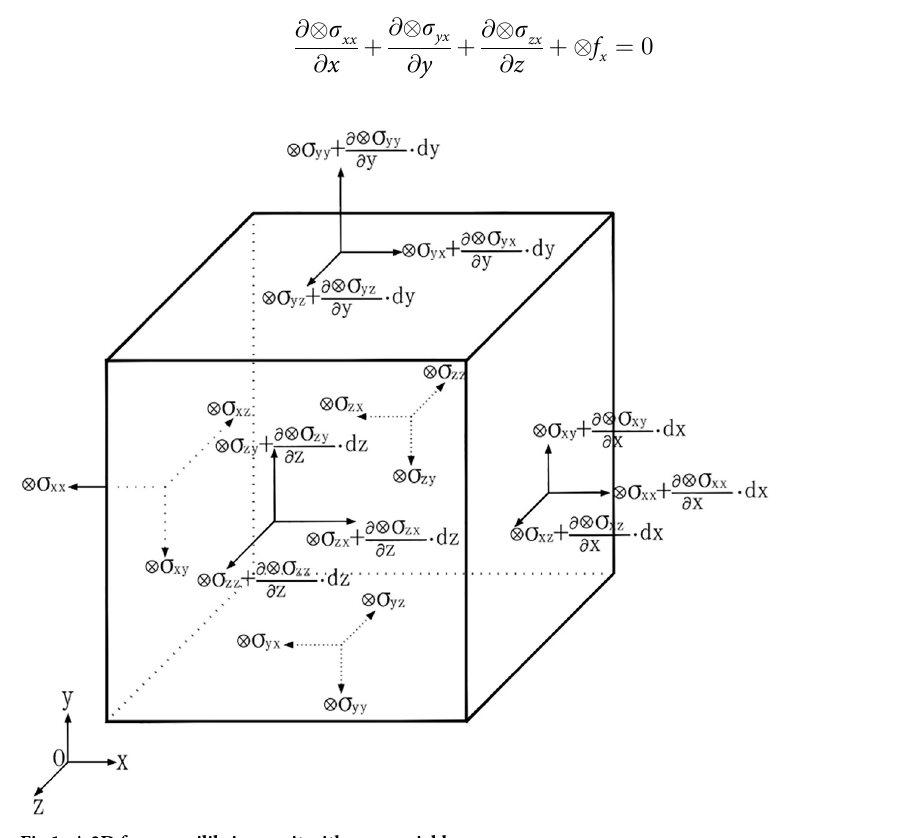
Fig 1. A 3D force equilibrium unit with grey